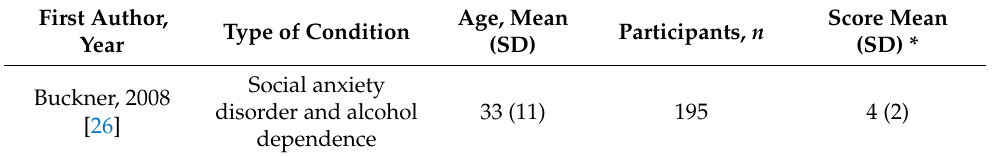
Table 5. Social anxiety-related impairment.